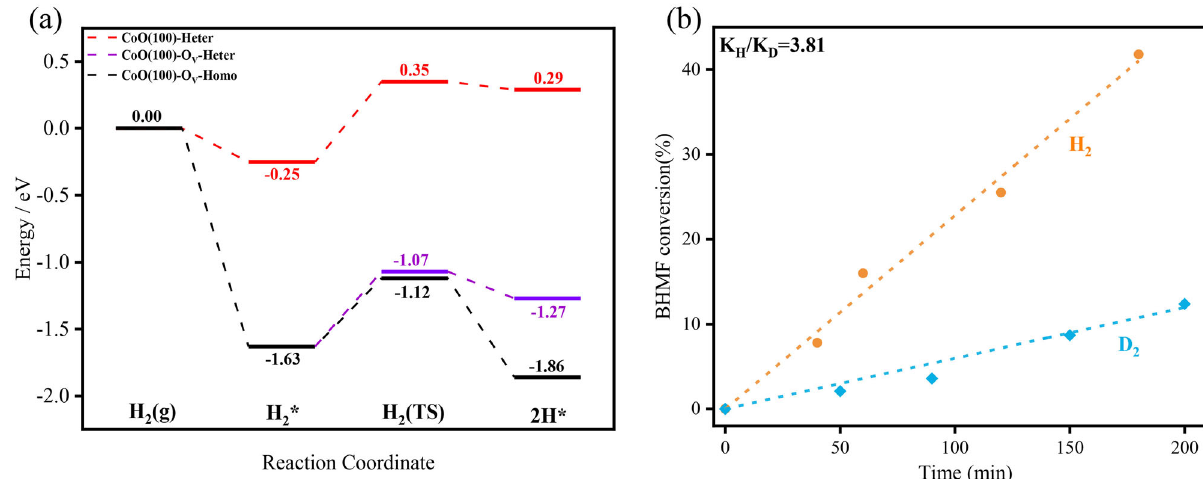
Fig. 5 Theoretical calculation and kinetic studies. a Calculated energy pro fi les of adsorption and dissociation of H 2 on the CoO(100) and CoO(100)-O V surfaces. H 2 (g): gas-phase H 2 ; H 2 *: adsorbed H 2 on surface; H 2 (TS): the adsorbed H 2 molecule on surface dissociates to two adsorbed H on surface; 2H*: the co-adsorption of two H on surface; b primary kinetic isotope effect observed for the HDO of 2,5-furandimethanol (BHMF). Reaction condition: BHMF,